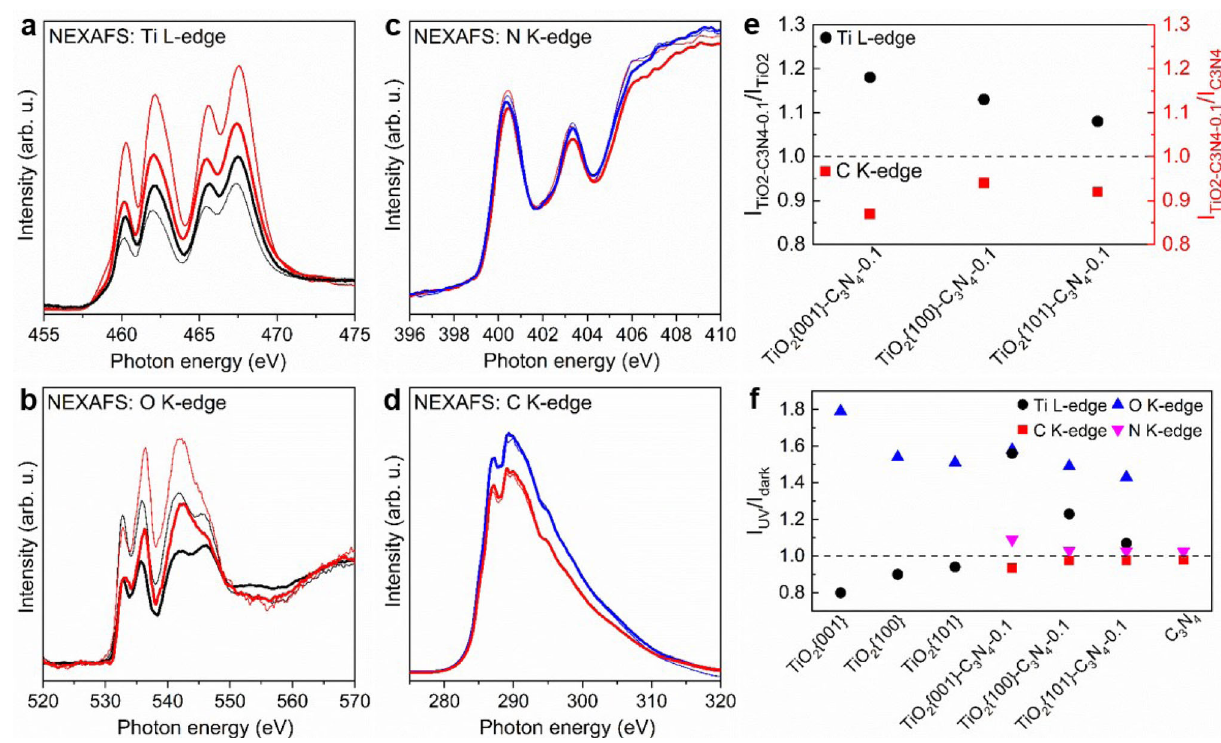
Fig. 3 | Interfacial chargetransfer. a TiL-edge, ( b ) O K-edge, ( c ) N K-edgeand ( d ) C K-edge NEXAFS spectra of TiO 2 {001} NCs (black line), TiO 2 {001} NCs-C 3 N 4 − 0.1 composite (red line) and C 3 N 4 (blue line) in dark (thick line) and under UV light illumination (thin line). e Ti L-edge intensity ratios of TiO 2 NCs-C 3 N 4 − 0.1